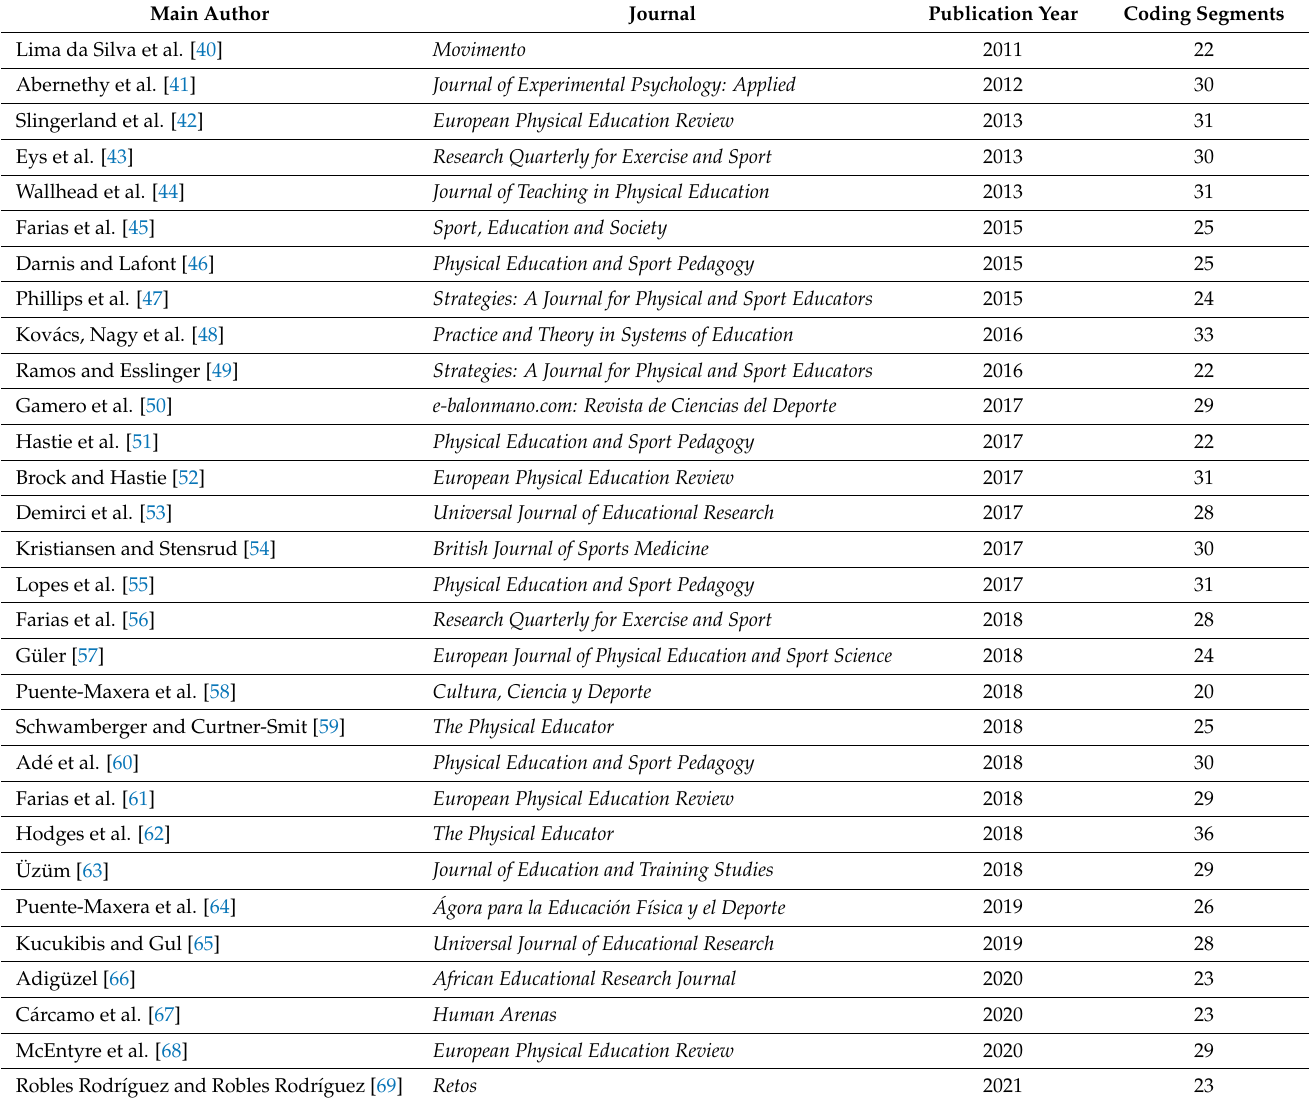
Table 1. Description of Articles